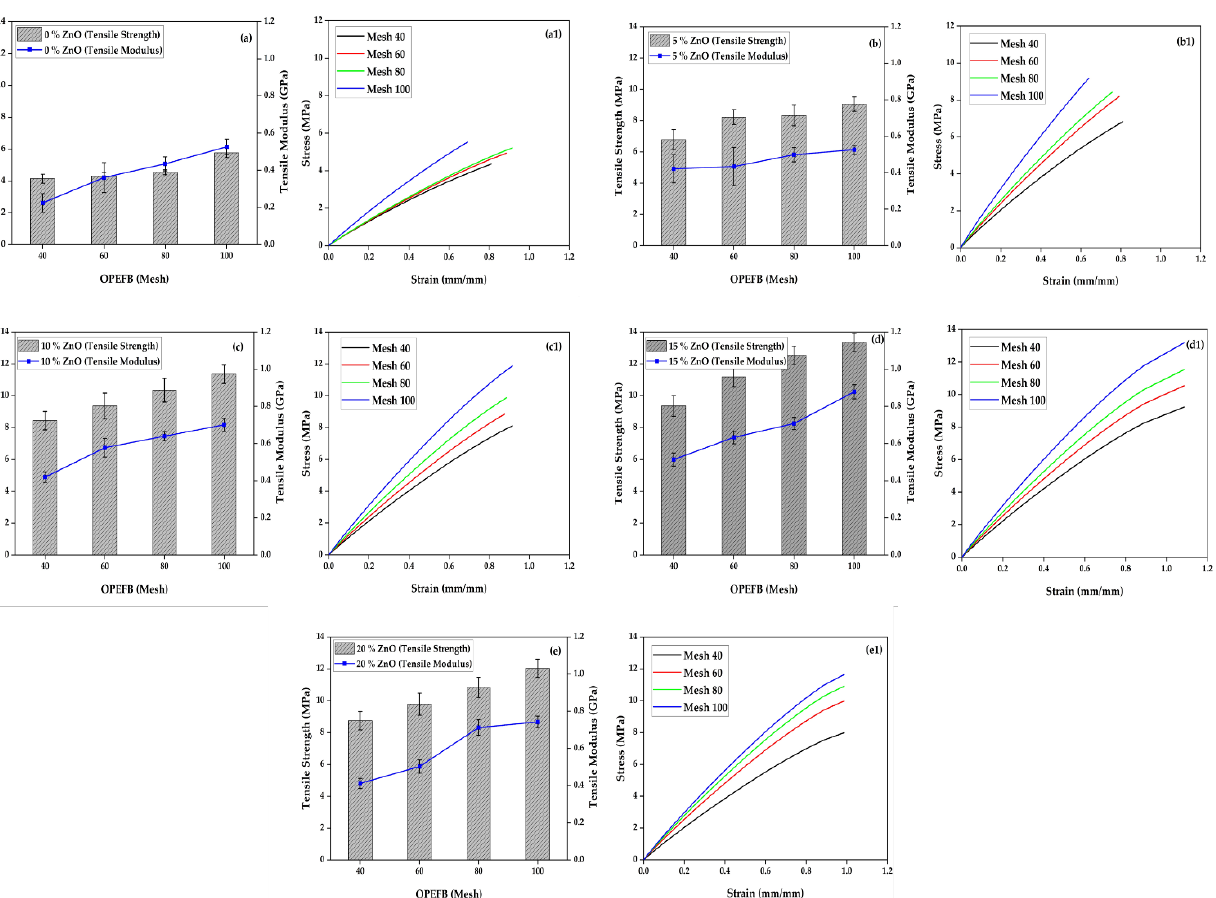
Figure 2. Tensile properties of foamed polymer composite at different OPEFB particle sizes and ZnO fillers, ( a ) 0% ZnO, ( b ) 5% ZnO, ( c ) 10% ZnO, ( d ) 15% ZnO, ( e ) 20% ZnO, ( a1 − e1 ) tensile stress–strain diagrams.